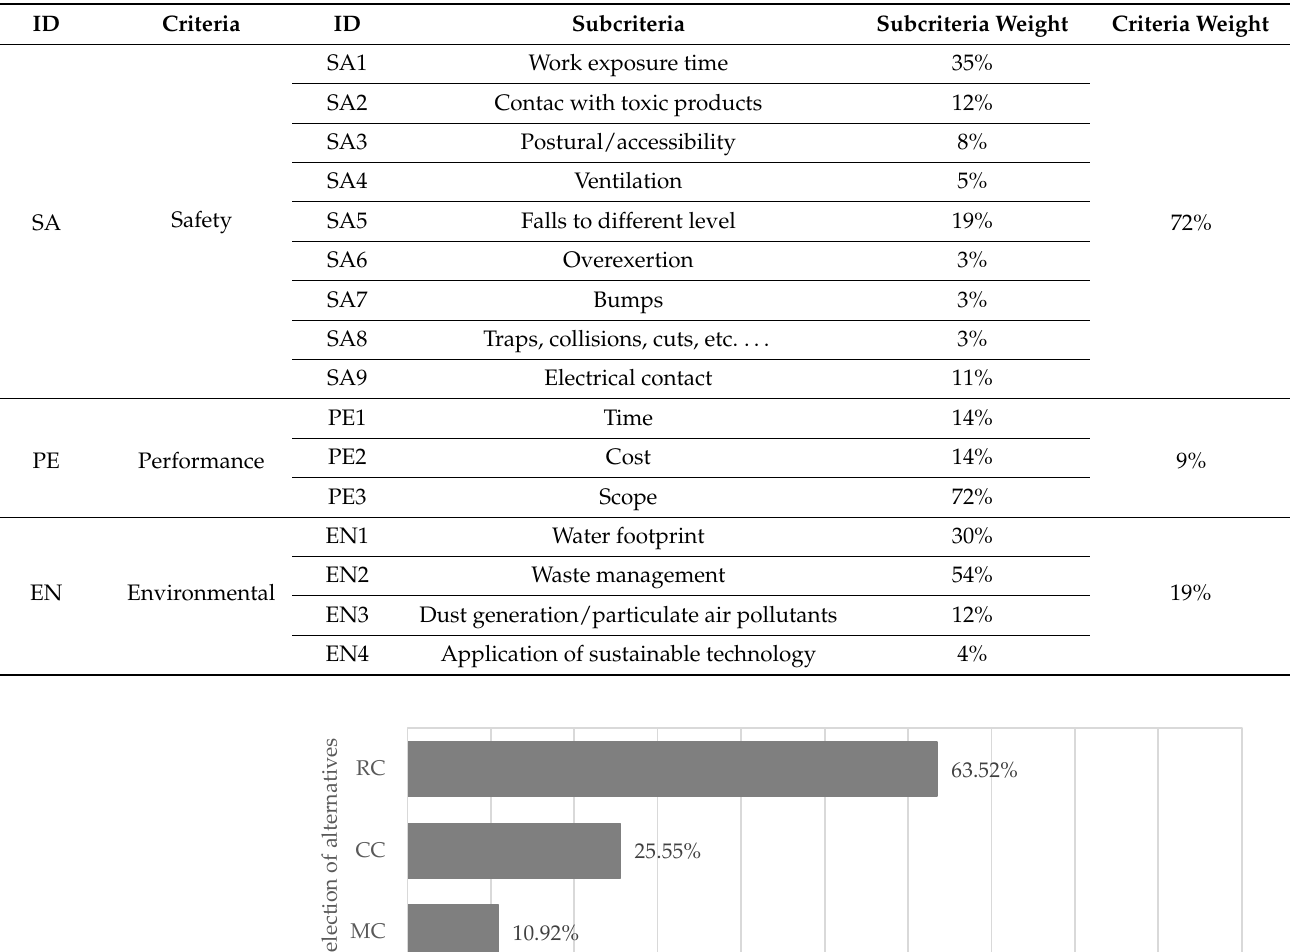
Table 7. Criteria and subcriteria local weighting summary.